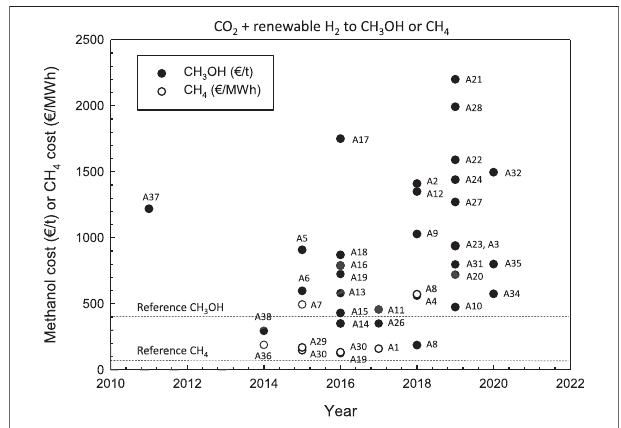
FIGURE 1 | An overview of the results in terms of costs of methanol production ( € /t) and of methane production ( € /MWh) in CO 2 conversion using H 2 produced from renewable energy sources. References: A1, Parra et al., 2017; A2, Asif et al., 2018; A3, Nieminen et al., 2019; A4, Moellenbruck et al., 2018; A5, Hannula, 2015; A6, Roh et al., 2015; A7, De Saint Jean et al., 2015;A8,Hoppeetal.,2018;A9,Hanketal.,2018;A10,Zhangetal.,2019b; A11, Rivarloo et al., 2017; A12, Michailos et al., 2018; A13 – A15, Kourkoumpas et al., 2016; A16 – A17, Rivera-Tinoco et al., 2016; A18, Atsonios et al., 2016; A19, Räuchle et al., 2016; A20 – A22, Nguyen Zondervan, 2019; A23, Alsayegh et al., 2019; A24, Nami et al., 2019; A25, Pérez-Fortes et al., 2016; A26, Gonzàlez-Aparicio et al., 2017; A27 – A28, Gonzàlez-Garay et al., 2019b; A29, Schiebahn et al., 2015; A30, Gutièrrez- Martin and Rodriguez-Anton, 2016; A31, Do and Kim, 2019; A32, Khunathorncharoenwong et al., 2020; A33, Tremel et al., 2015; A34, Zhang and Desideri, 2020; A35, Bos et al., 2020; A36, Hofstetter et al., 2014; A37, Kim et al., 2011; A38, Barbato et al., 2014. Original Figure.